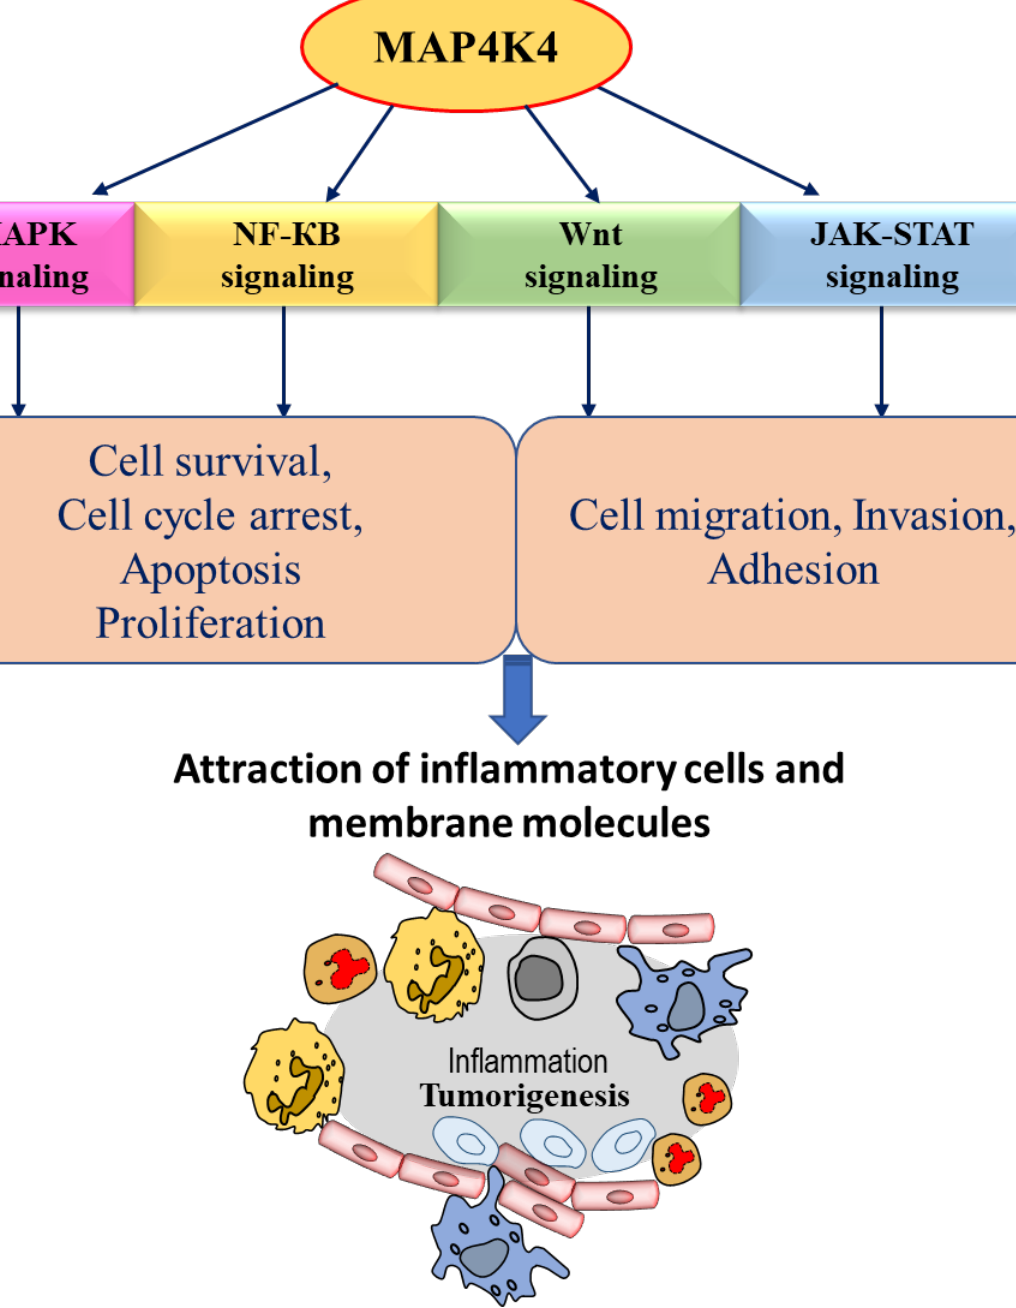
Figure 2. Schematic diagram representing MAP4K4 downstream signaling in cancer. MAP4K4 regulates different biological outcomes through different cell signaling pathways, implicating that MAP4K4 exerts its role in regulating the tumorigenesis process.